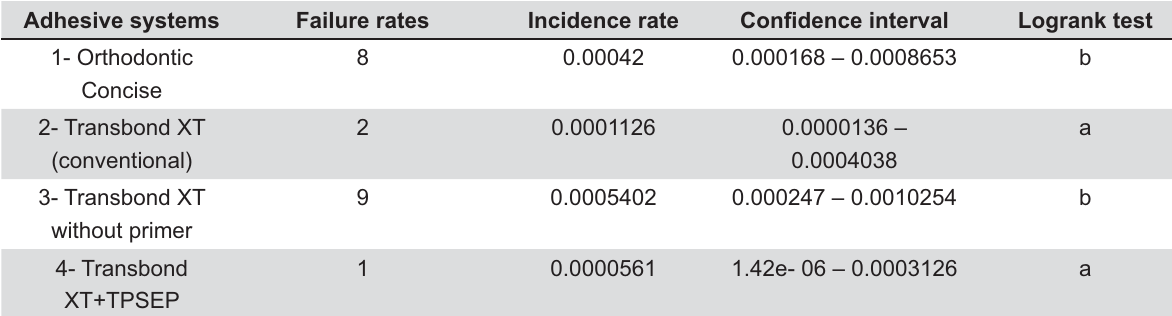
Table 2- (cid:4)<(cid:7)(cid:12)(cid:22)(cid:26)(cid:8)(cid:6)(cid:4)(cid:8)(cid:7)(cid:14)(cid:6)(cid:9)(cid:18)(cid:4)(cid:12)(cid:16)(cid:11)(cid:12)(cid:13)(cid:6)(cid:16)(cid:11)(cid:6)(cid:4)(cid:8)(cid:7)(cid:14)(cid:6)(cid:18)(cid:4)(cid:7)(cid:16)(cid:13)(cid:4)(cid:11)(cid:23)(cid:16);(cid:13)(cid:6)(cid:16)(cid:11)(cid:6)(cid:4)(cid:12)(cid:16)(cid:14)(cid:6)(cid:8)=(cid:7)(cid:22)(cid:4)(cid:27)?GH(cid:29)(cid:4)(cid:24)(cid:23)(cid:8)(cid:4)(cid:6)(cid:7)(cid:11)(cid:15)(cid:4)(cid:7)(cid:13)(cid:15)(cid:6)(cid:9)(cid:12)=(cid:6)(cid:4)(cid:9)(cid:5)(cid:9)(cid:14)(cid:6)(cid:19)